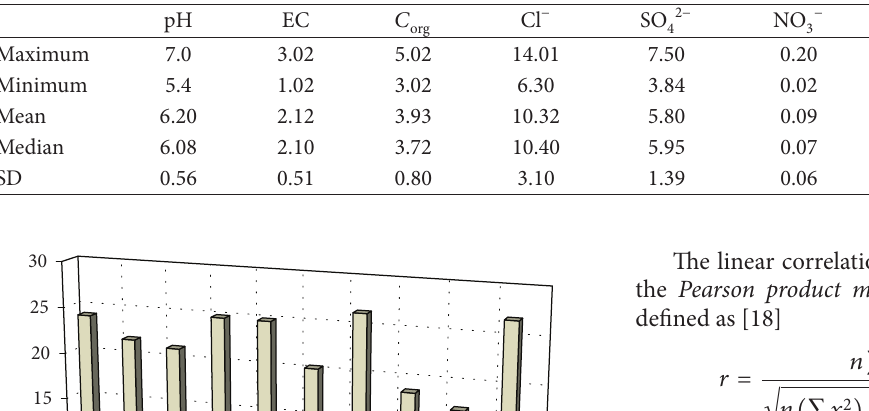
T 2: Statistics of the elements and physicochemical parameters in soil samples (